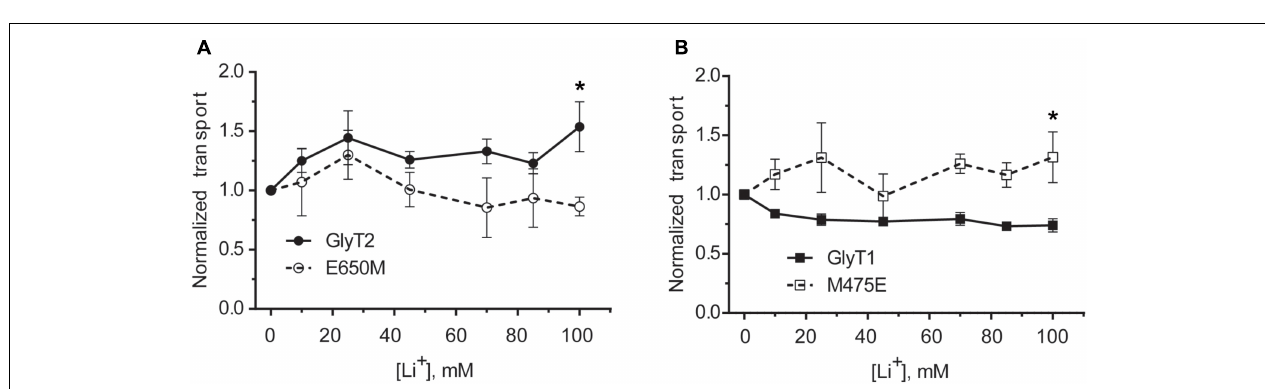
FIGURE 7 | Reversal potential of wild-type and GlyT2-E650M mutant-mediated currents as a function of the external Na + concentration. (A,B) GlyT2 oocytes injected with 18 nM of glycine and NaCl: current-voltage relationships (A) and E Rev plotted as a function of the log [Na + ]o (B) . (C,D) GlyT2-E650M oocytes injected with 18 nM of glycine: current-voltage relationships (C) and E Rev plotted as a function of the log [Na + ]o (D) . Linear regression equation is presented in the graphs.